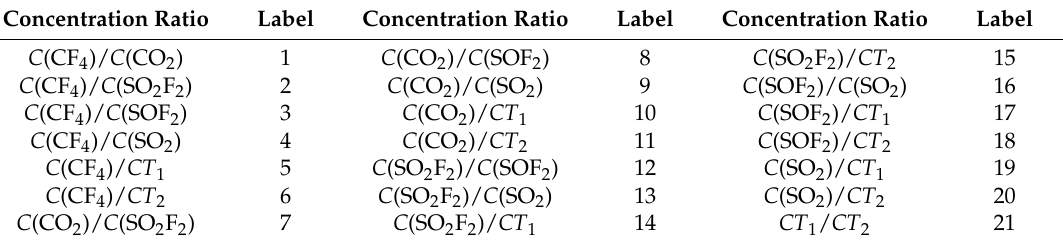
Table 3. Concentration ratios for PD severity diagnosis and their corresponding